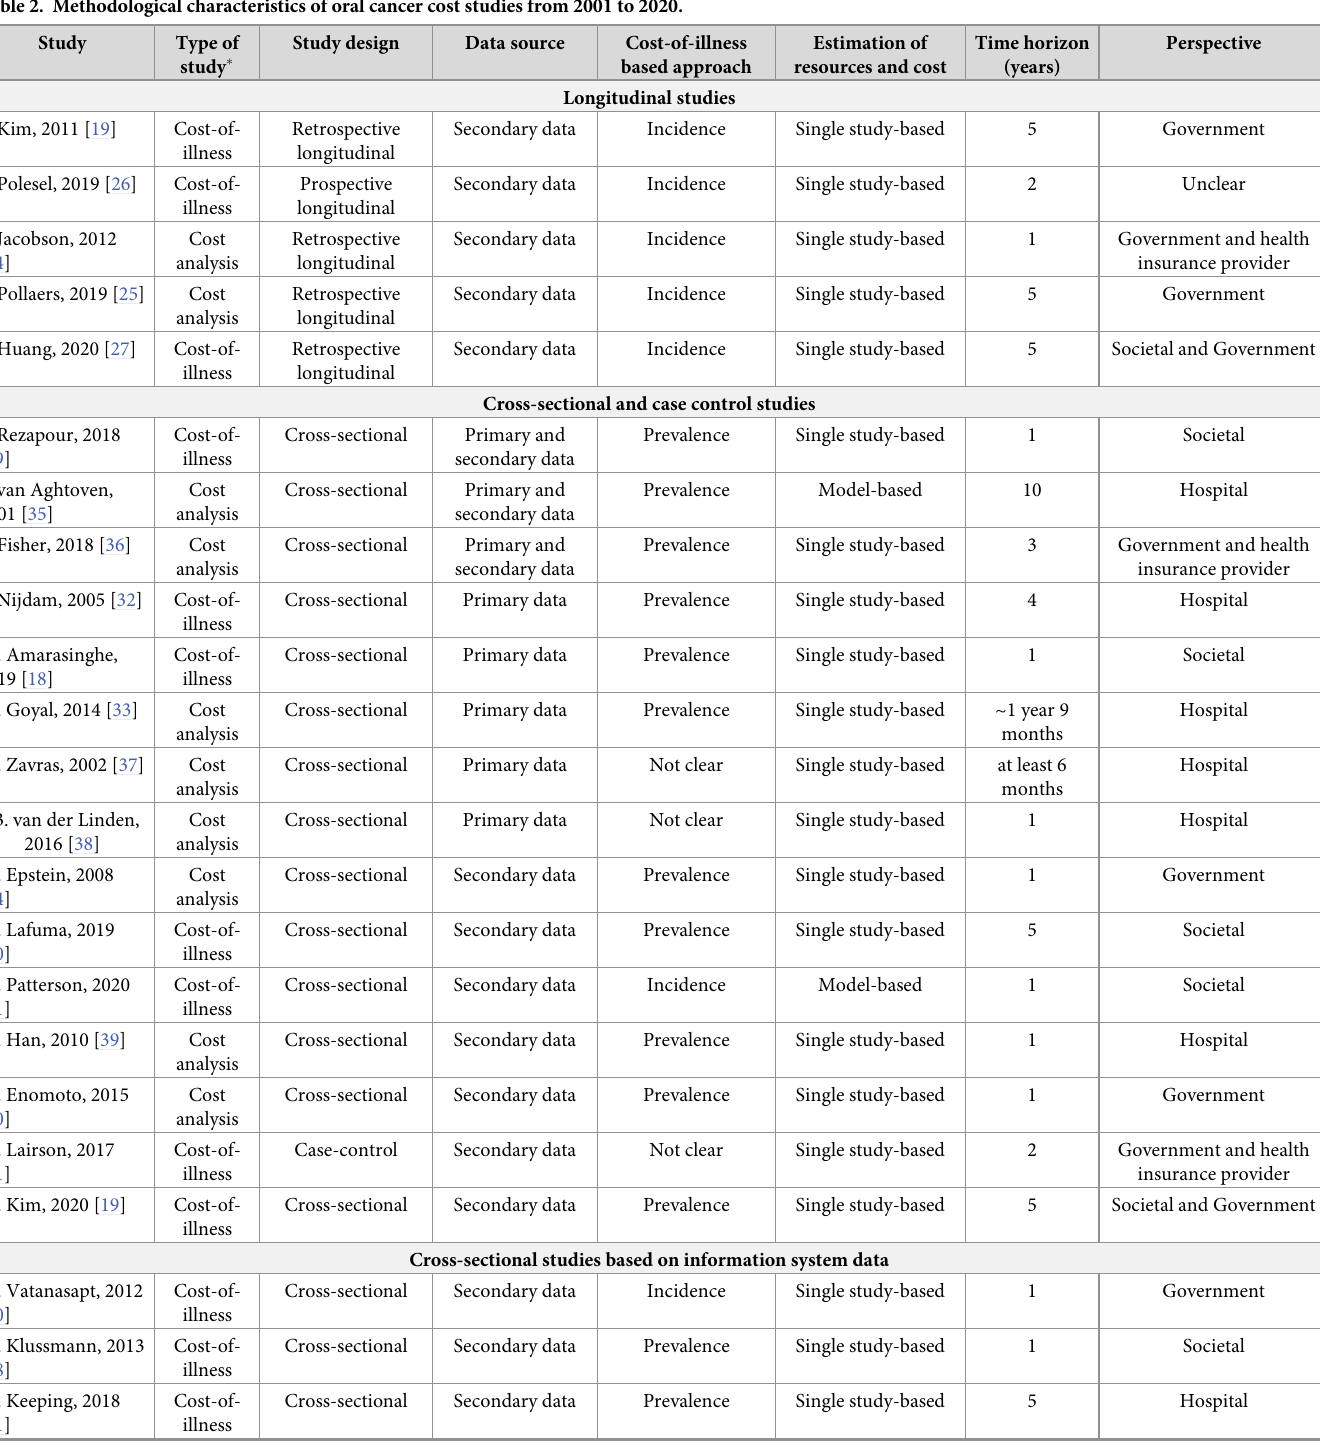
Table 2. Methodological characteristics of oral cancer cost studies from 2001 to